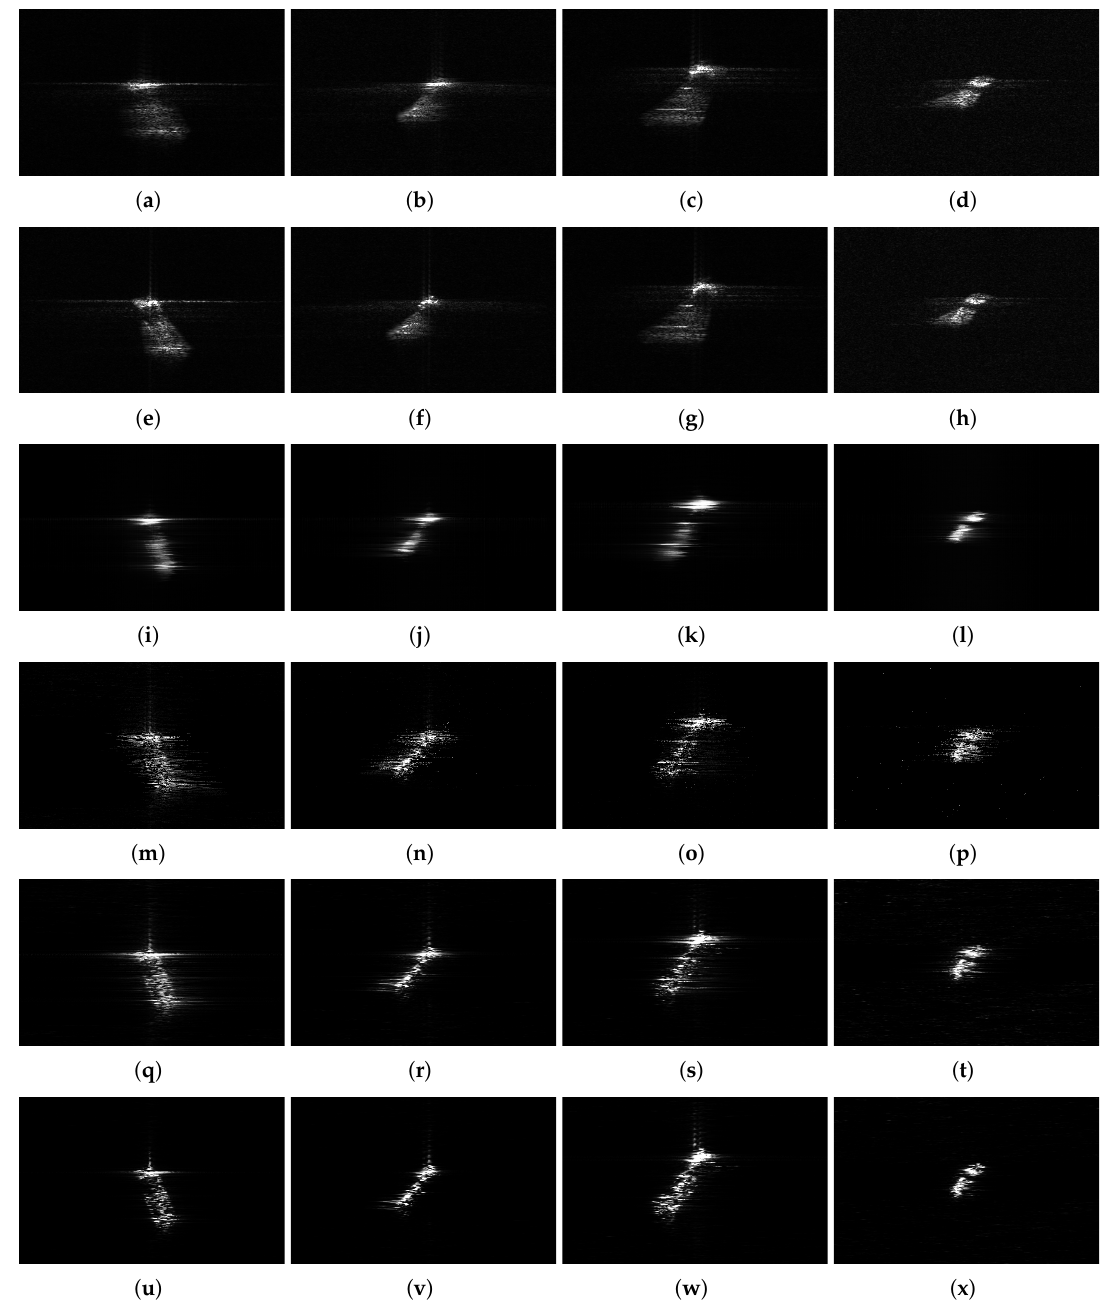
Figure 9. Gaofen-3 ship images of S1, S2, S3 and S4. ( a – d ) Original ship images of S1, S2, S3 and